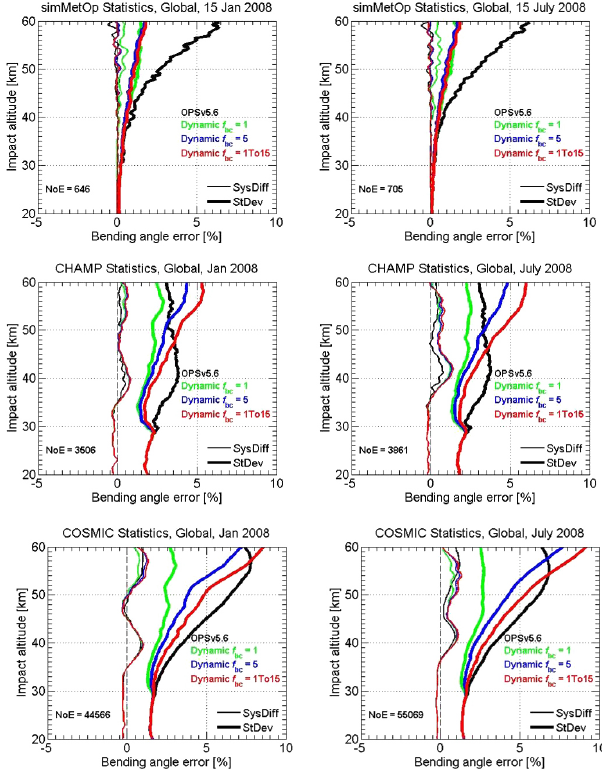
Figure 8. Systematic differences (SysDiff, light lines) and standard deviations (SD, heavy lines) of statistically optimized bending an- gles, relative to “perfect” simulated bending angles or co-located ECMWF analysis bending angles used as a reference, of the global ensemble of simMetOp events on 15 January and 15 July 2008 (up- per two panels), and of CHAMP and COSMIC events from the com- plete months of January and July 2008 (middle and bottom panel, respectively). Statistics of the OPSv5.6 (black), b-dynamic (blue), dynamic (red), CDAAC (version 2009.2650 for CHAMP and ver- sion 2010.2640 for COSMIC, green), and CDAAC new (version 2014.0140 for CHAMP, magenta) statistical optimization methods are shown. The number of events (NoE) used in the ensemble of each statistical calculation is also indicated in each panel.